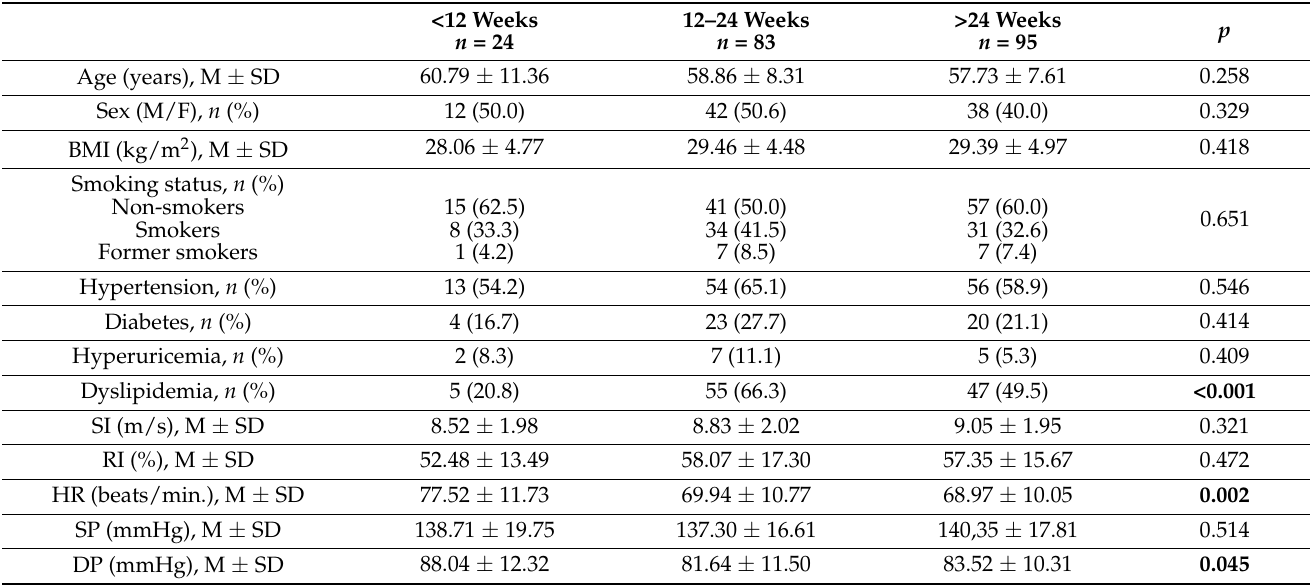
Table 3. Comparisons between the subgroups of COVID-19 convalescents depending on the time from the disease onset (i.e., <12 weeks, 12–24 weeks, and >24 weeks).